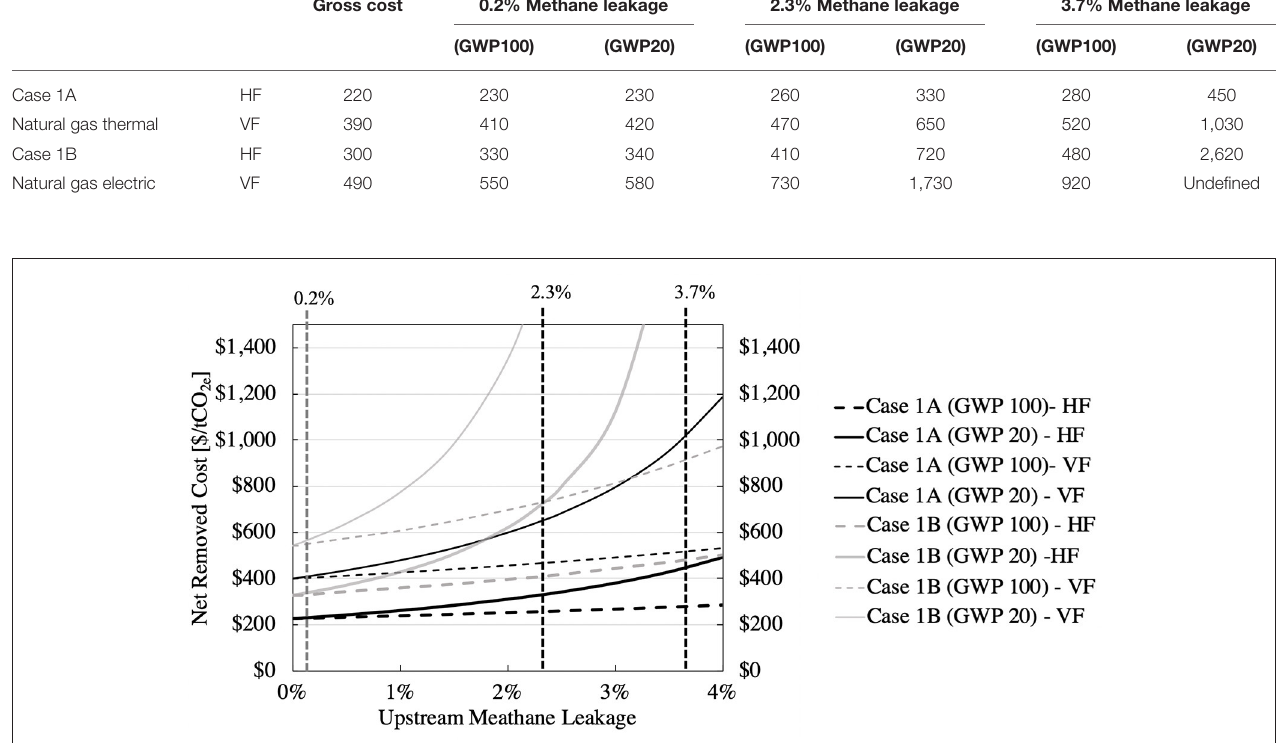
FIGURE 5 | Sensitivity of the net removal cost to the upstream leakage percentage of methane. The three vertical lines correspond to the entries in Table 4 (see text).